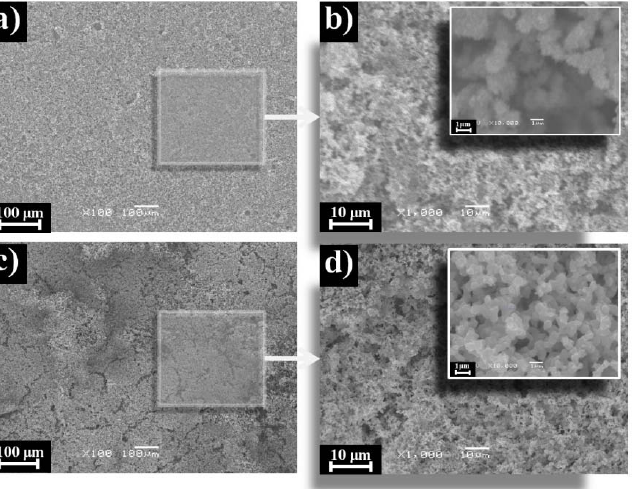
Figure 5. SEM micrographs surface of ( a , b ) as-deposited and ( c , d ) heat-treated HAP coating de- posited with 9% H 2 O 2 .